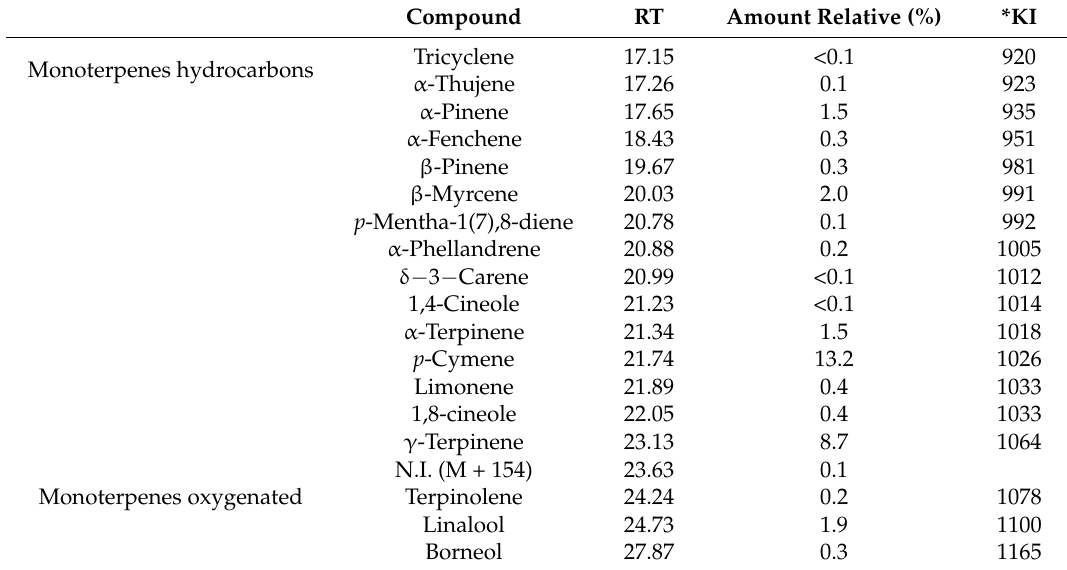
Table 1. Volatile compounds expressed as area percentage, identified in the Thymus capitatus essential oil